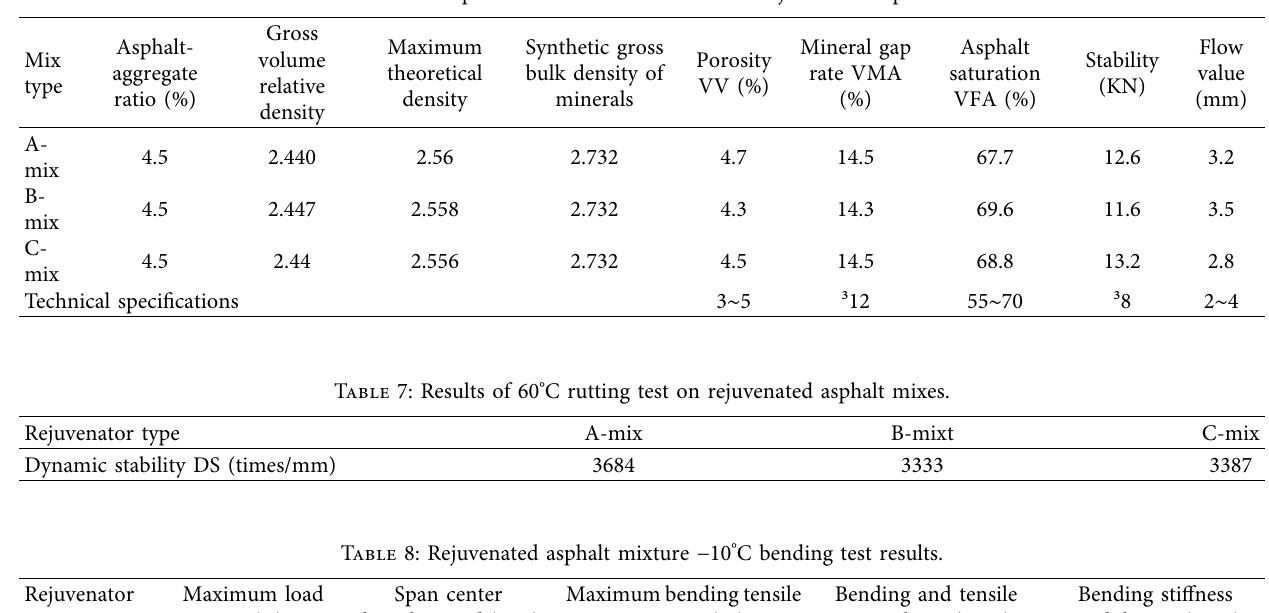
Table 6: Marshall specimen test results of different rejuvenated asphalt mixes.